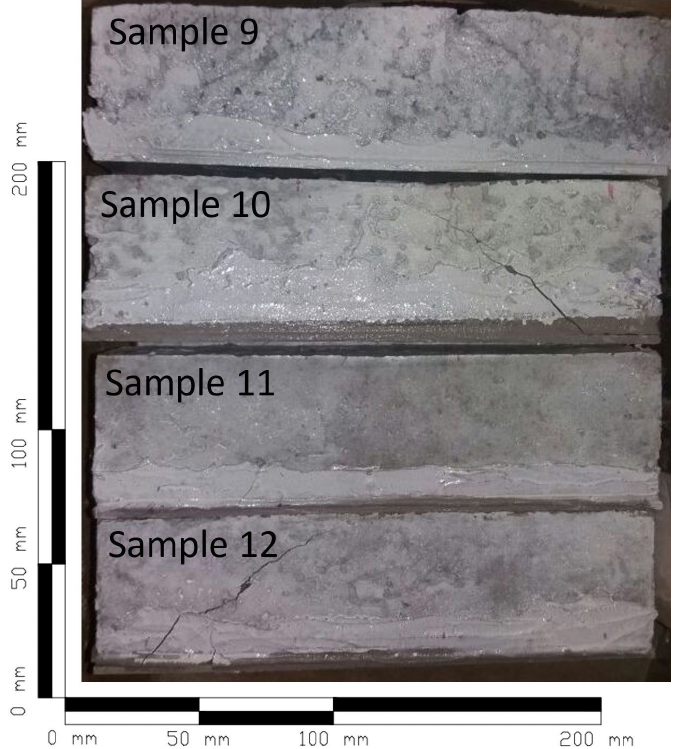
Figure 16. Cracking propagation behavior of FRP-G hybrid beams (Samples 9 to 12).